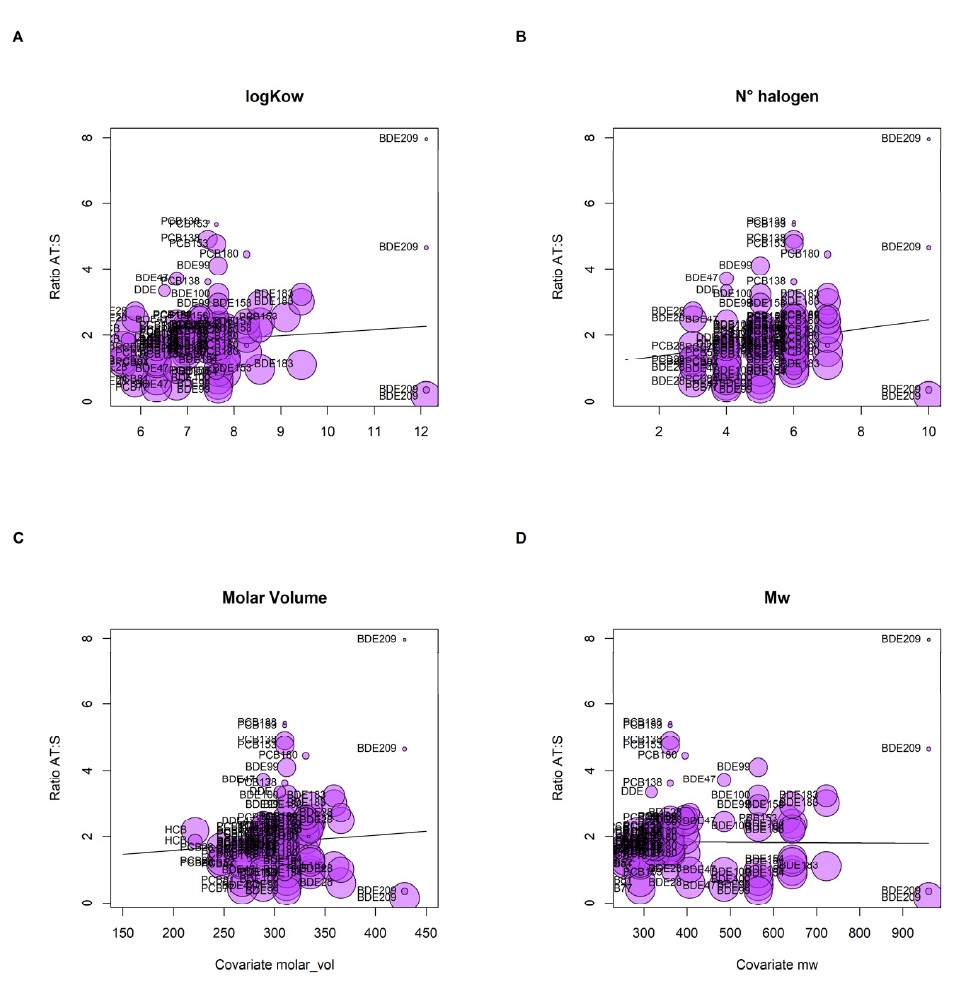
Figure 2. Bubble plots representing the associations between the mean partitioning ratios of persistent organic pollutants between adipose tissue and serum reported in the literature and physicochemical properties, including the partition octanol – water (Log K ow , Panel A ), number of halogen atoms (Panel B ), molar volume (Panel C ) and molar weight (Mw, Panel D ).